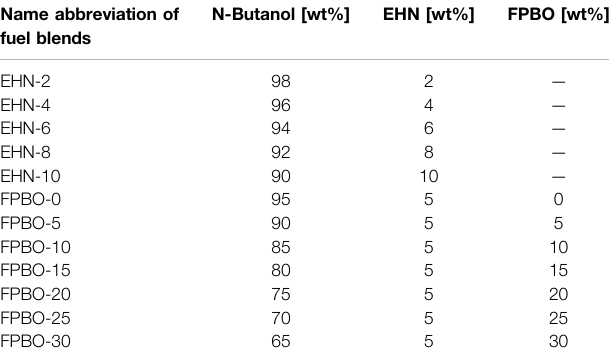
TABLE 2 | Compositions of tested fuel blends (1,000 ppm of lubricity enhancer, In fi neum R655, is added in all the blended fuels). Name abbreviation of fuel